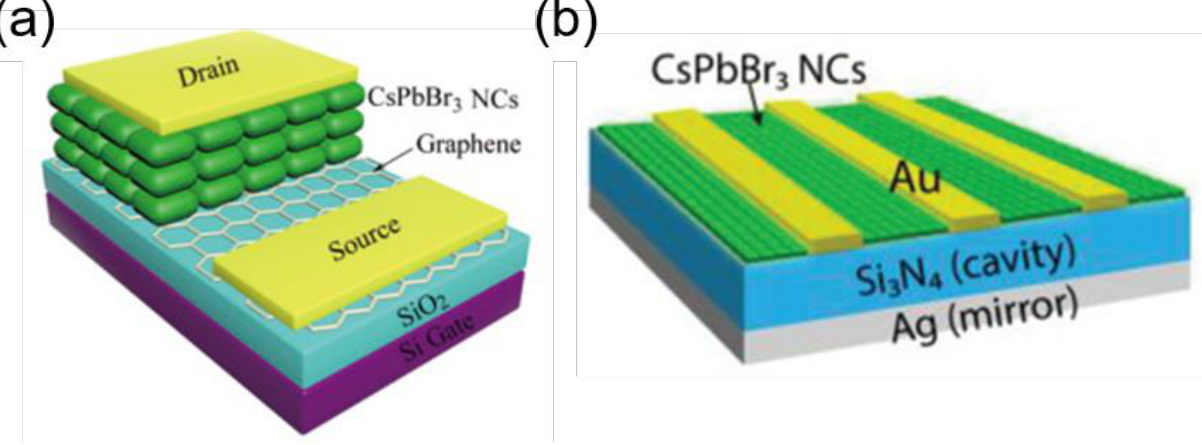
Figure 14. ( a ) Schematic drawing of the perovskite NC-based VFEPT [22]. Copyright 2020 Elsevier. ( b ) Schematic diagram of perovskite NC-based photodetector enabling photodetection at telecom- munication wavelengths [84]. Copyright 2021 John Wiley & Sons, Inc. Table 5. Summary of rising time and decay time of hybrid graphene – perovskite NC photodetec- tors.